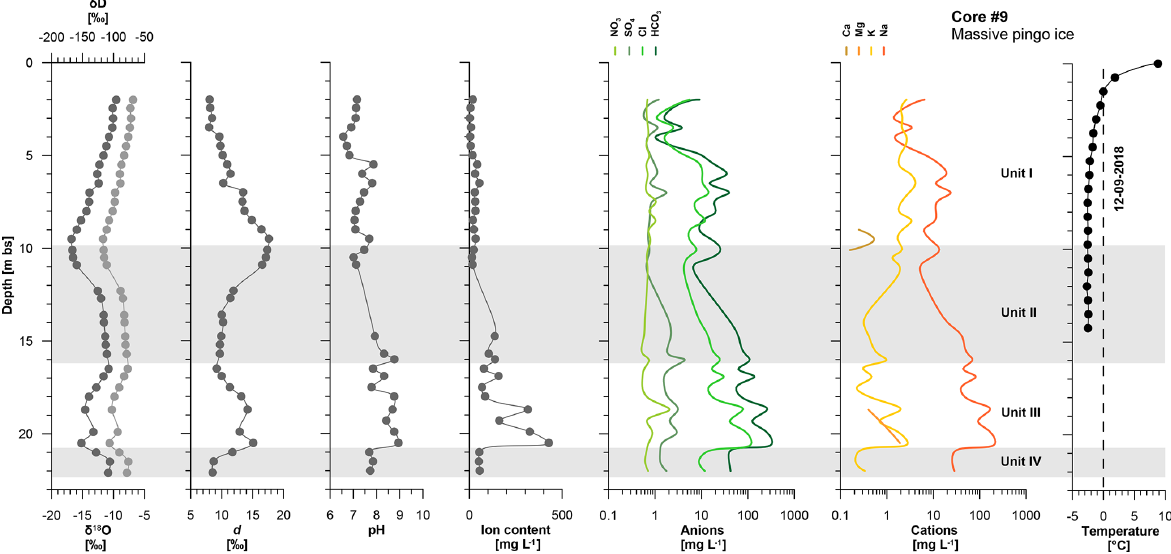
Figure 4. Hydrochemical composition of water extracts from the sedimentary cores 9, 10 and 11. Data are given in Table 3. Note different axis scale for ion content in (a) reaching up to 1335mgL − 1